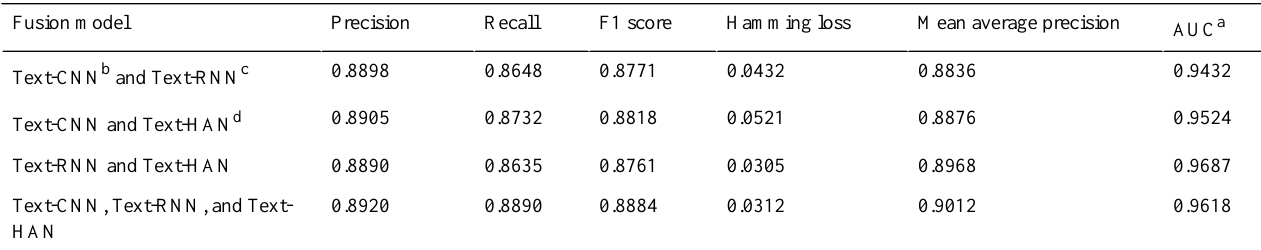
Table 4. Fusion models for multilabel